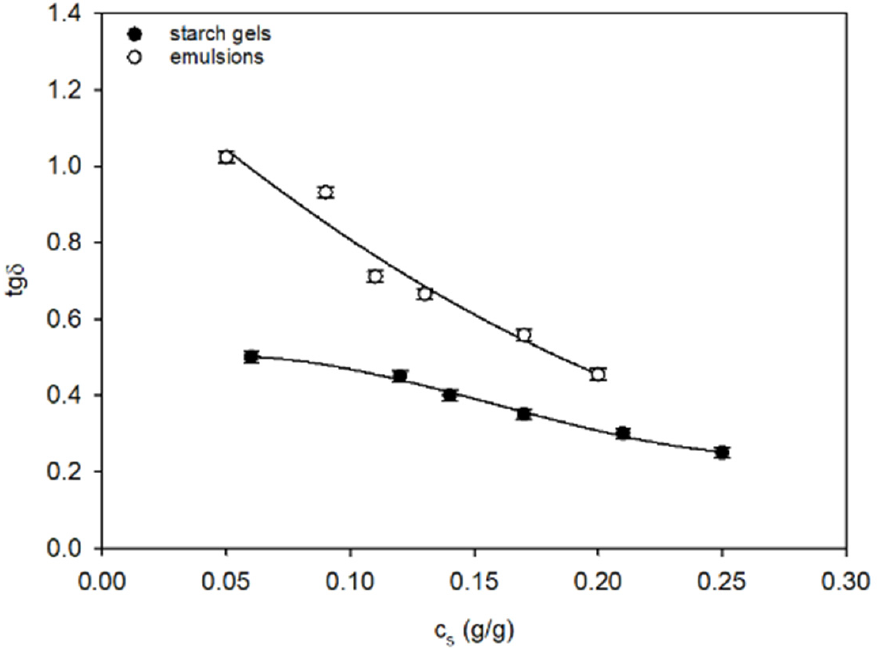
Figure 6. The tg δ in the process of formation of the starch gels and starch–fat emulsions. The values are expressed as means ± SD ( n = 3).